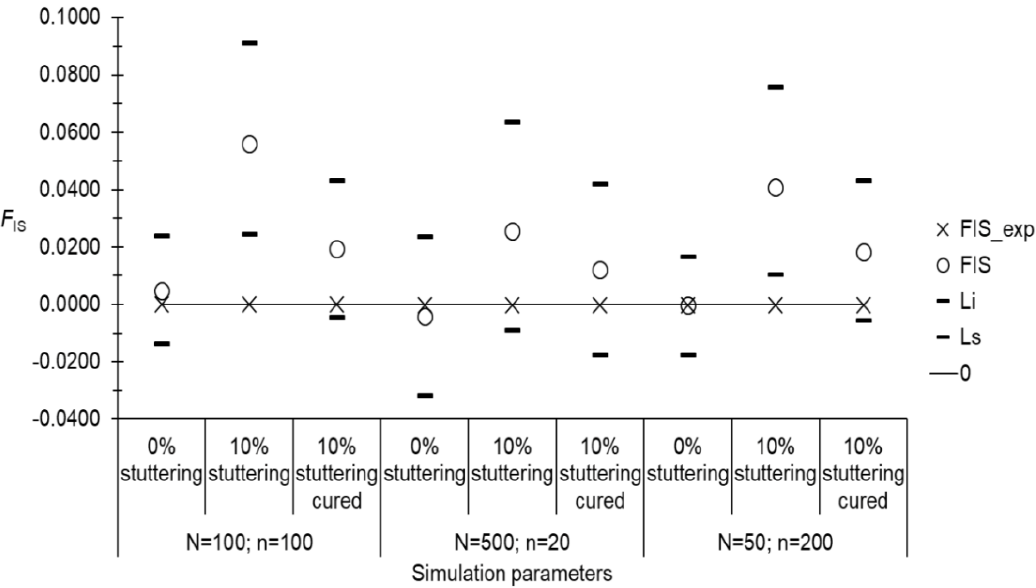
Figure 3: Comparison of Wright's F IS estimates obtained in different simulations in dioecious pangamic populations, without stuttering, with 10% stuttering and with 10% stuttering cured data. The F IS_exp , according to Vitalis (2002), is represented, as are the line of F IS =0, and 95% bootstraps confidence intervals (Li and